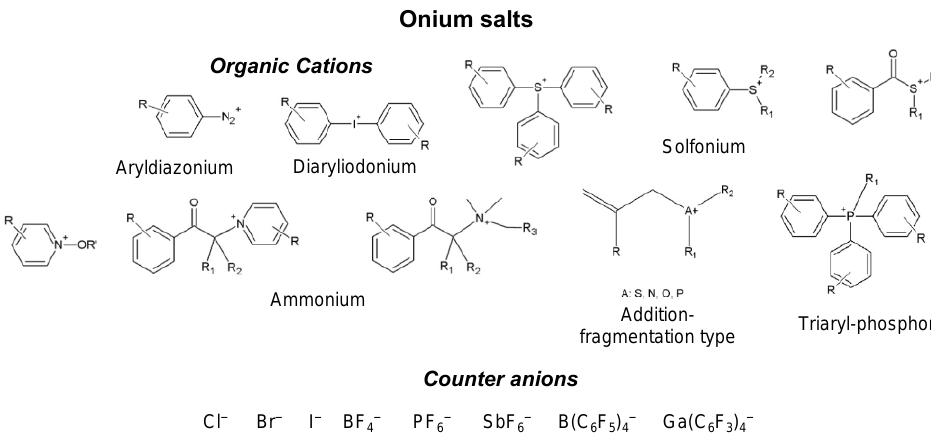
Figure 3. Chemical structures of the most commonly used onium salts.